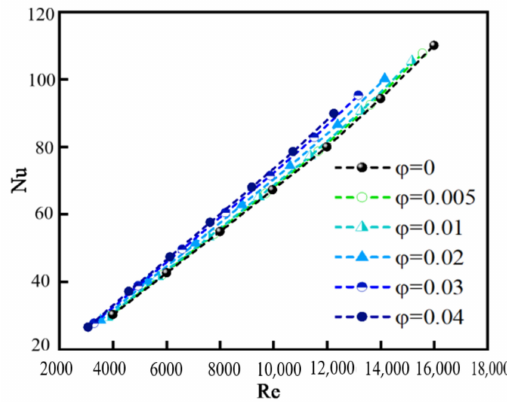
Figure 14. Relationship between Nu and Re for different ϕ